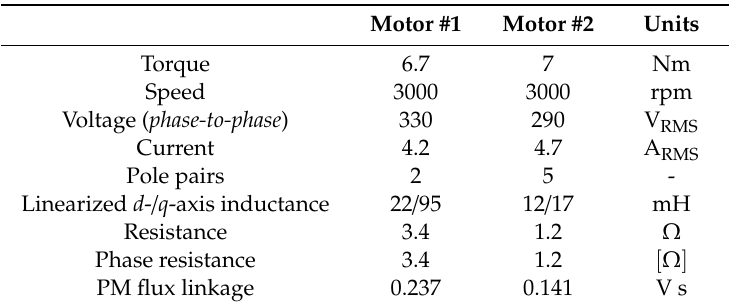
Table 1. Rated Parameters of Interior Permanent Magnet (IPM) Machines.